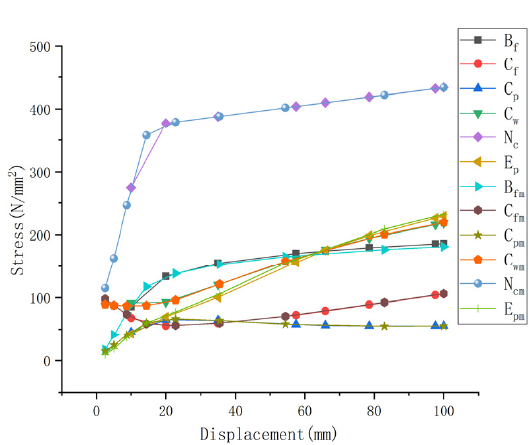
Figure 8. Comparison of the stress history of the prototype and the model.